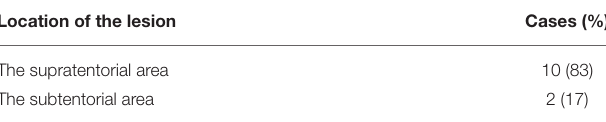
TABLE 1 | The location distribution of cerebral